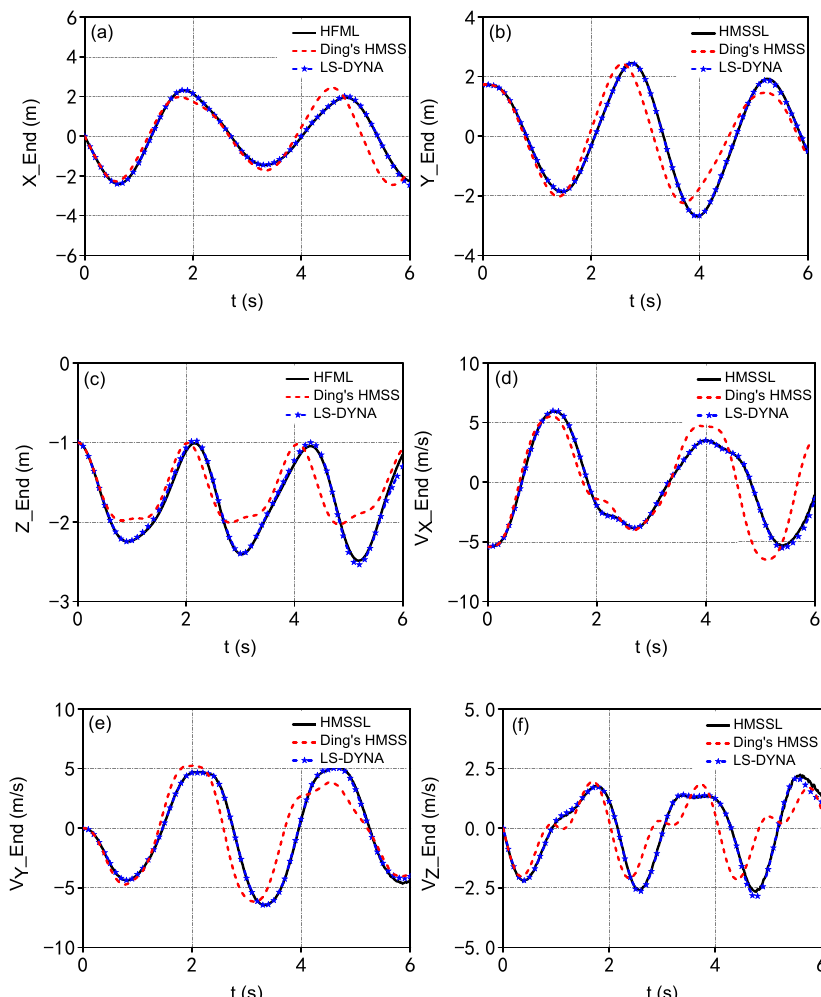
Figure 4. Position and velocity components for 1-element simulations: ( a ) X -axial component of lumped weight position, ( b ) Y -axial component of lumped weight position, ( c ) Z -axial component of lumped weight position, ( d ) X -axial component of lumped weight velocity, ( e ) Y -axial component of lumped weight velocity, ( f ) Z -axial component of lumped weight velocity.